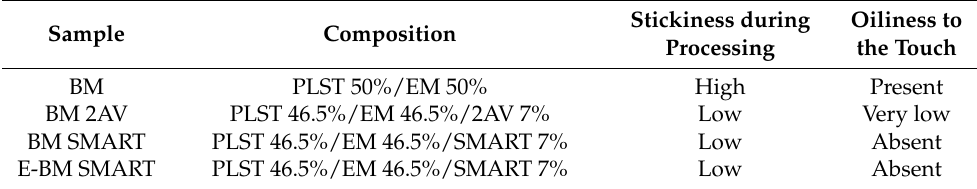
Table 2. Compositions of investigated materials and evaluation of stickiness during processing (detaching from Teflon sheets) and oiliness to the touch. Sample Composition